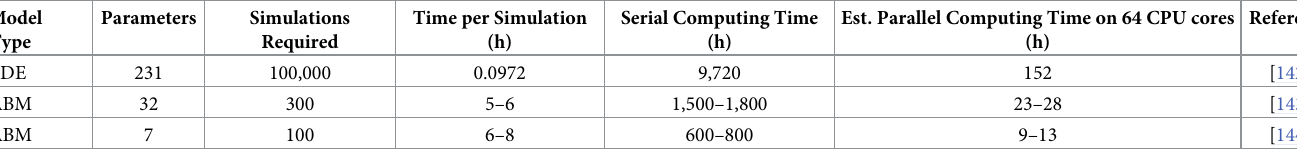
Table 2. Requirements for generating training data for microbial community models. Model